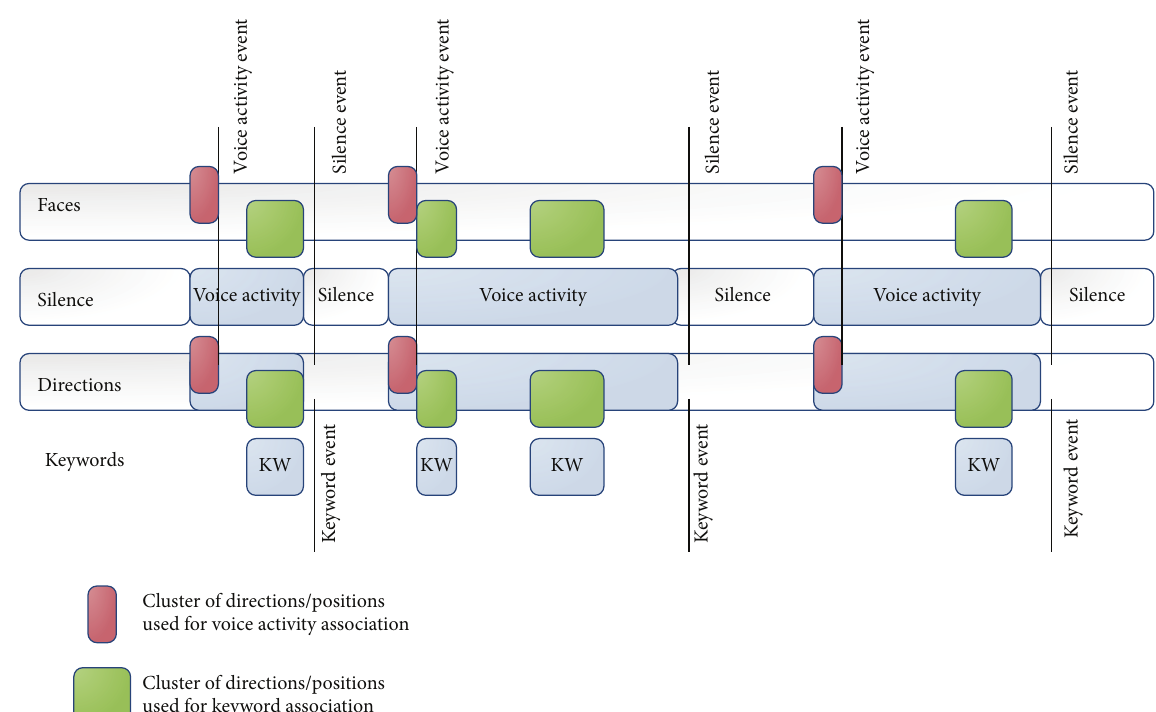
Figure 10: Low delay association and fusion. The voice activity is associated with direction of arrival and detected face at the moment of voice activity confirmation and not at the moment when the voice activity is